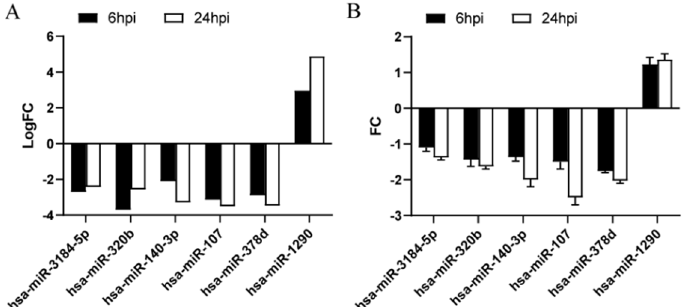
Figure 5. Key DE-miRNA validation by qRT-PCR. ( A ) logFC value of MTB-1458-infected cells vs. uninfected cells according to sequencing data. ( B ) THP-1 cells were infected with MTB-1458 at a MOI of 10 for 12 h. Cells were washed twice and a medium containing gentamycin (100 μ g/mL) was added. At 6 and 24 hpi, total RNA was collected. The expression level of DE-miRNAs was measured by qRT-PCR and normalized with U6 as an internal reference.